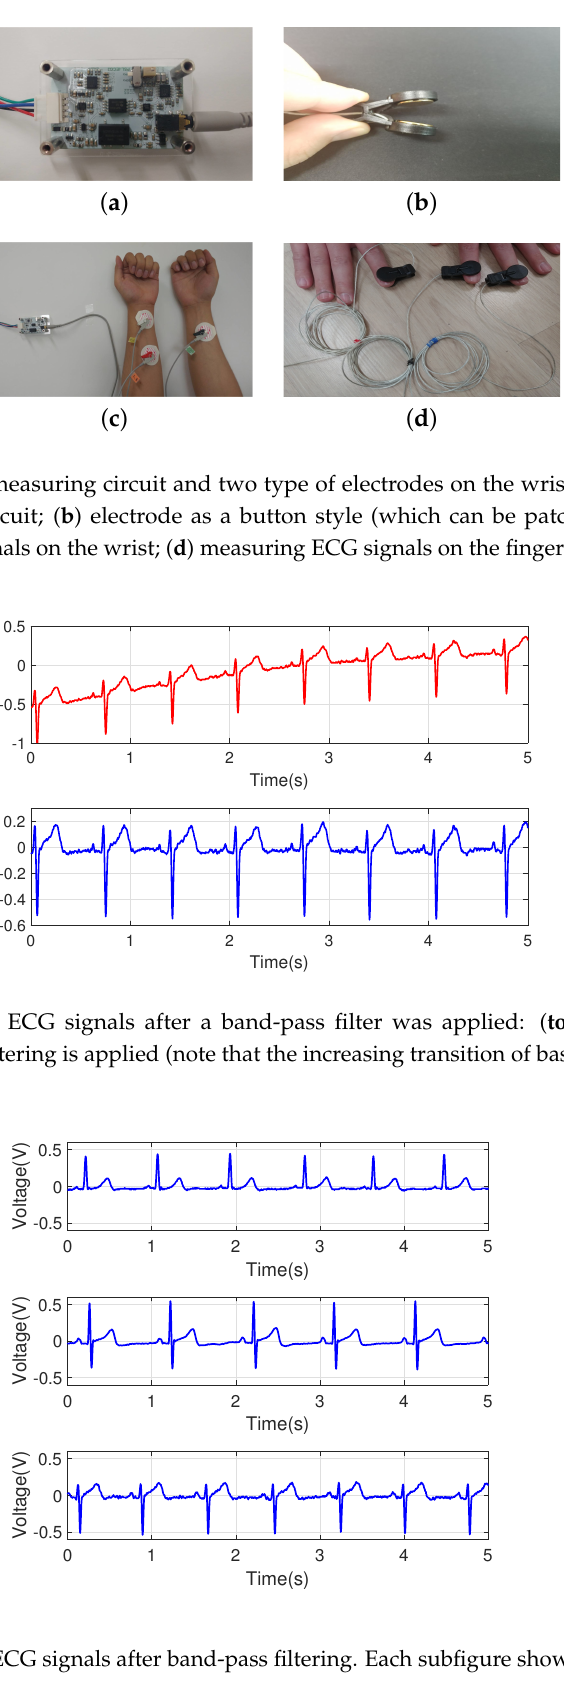
Figure 4. Examples of ECG signals after band-pass filtering. Each subfigure shows the results of three different